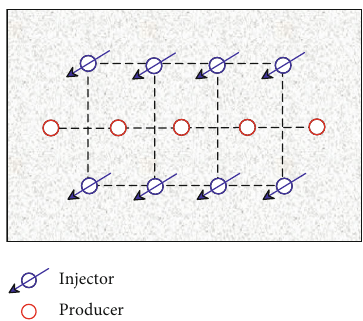
Figure 1: Schematic of the line drive pattern widely employed in o ff shore oil fi elds. The water injection wells are usually arranged in a straight line parallel to the production wells.